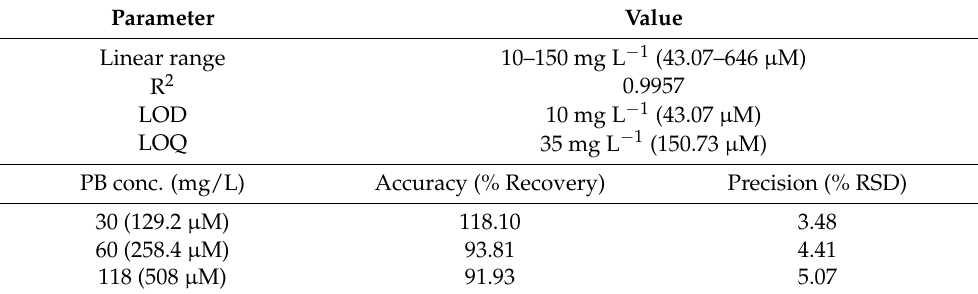
Table 4. Analytical performance of CuOEP 3 electrode to phenobarbital (PB) determination in aque- ous